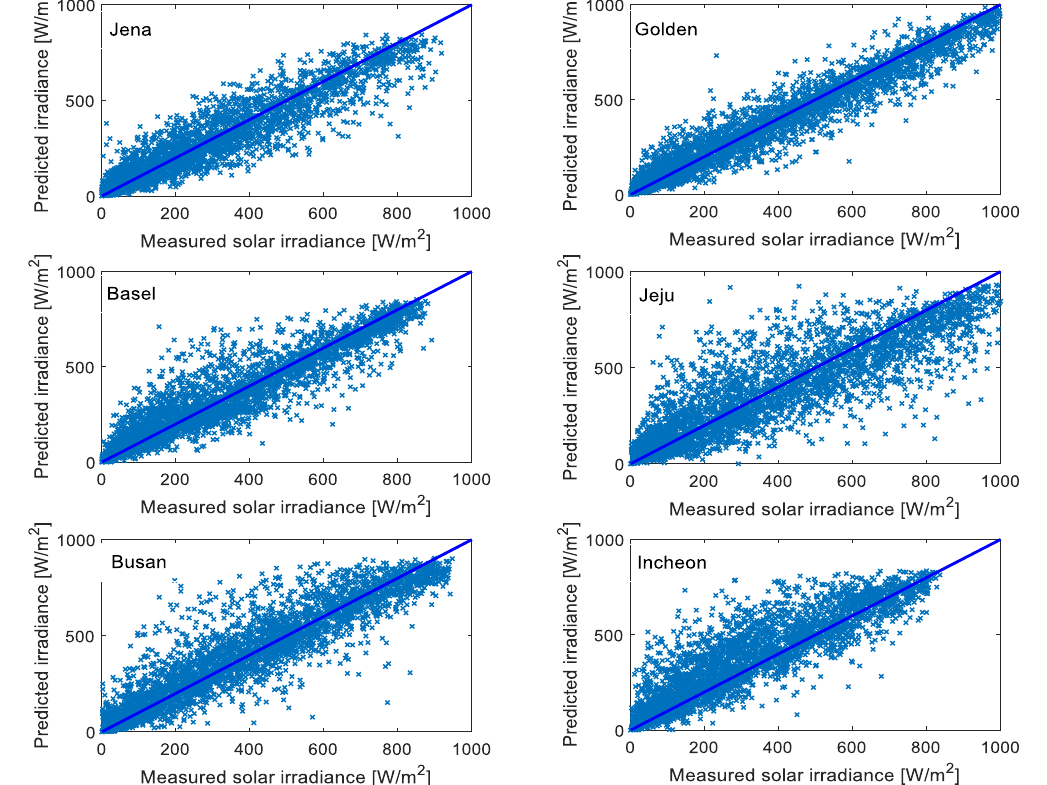
Figure 7. Scatter plots of the measured and predicted solar irradiance for the proposed approach.